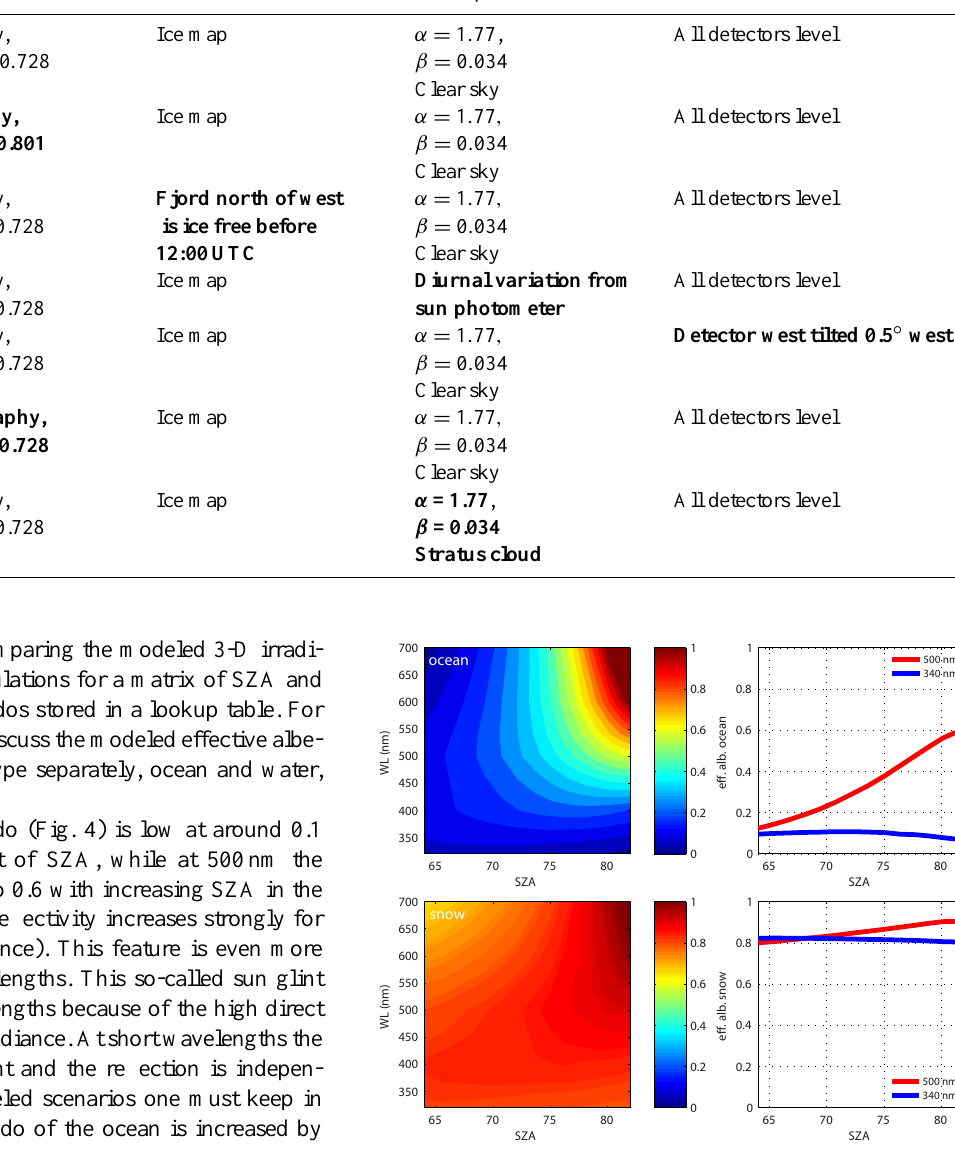
The effective snow albedo in the standard scenario is about 0.81 at 340 nm and essentially independent of SZA, resembling a Lambertian surface. For longer wavelengths (500 nm), the albedo becomes SZA dependent and increases from 0.8 at 65 ◦ SZA to 0.9 at 84 ◦ SZA. Since the